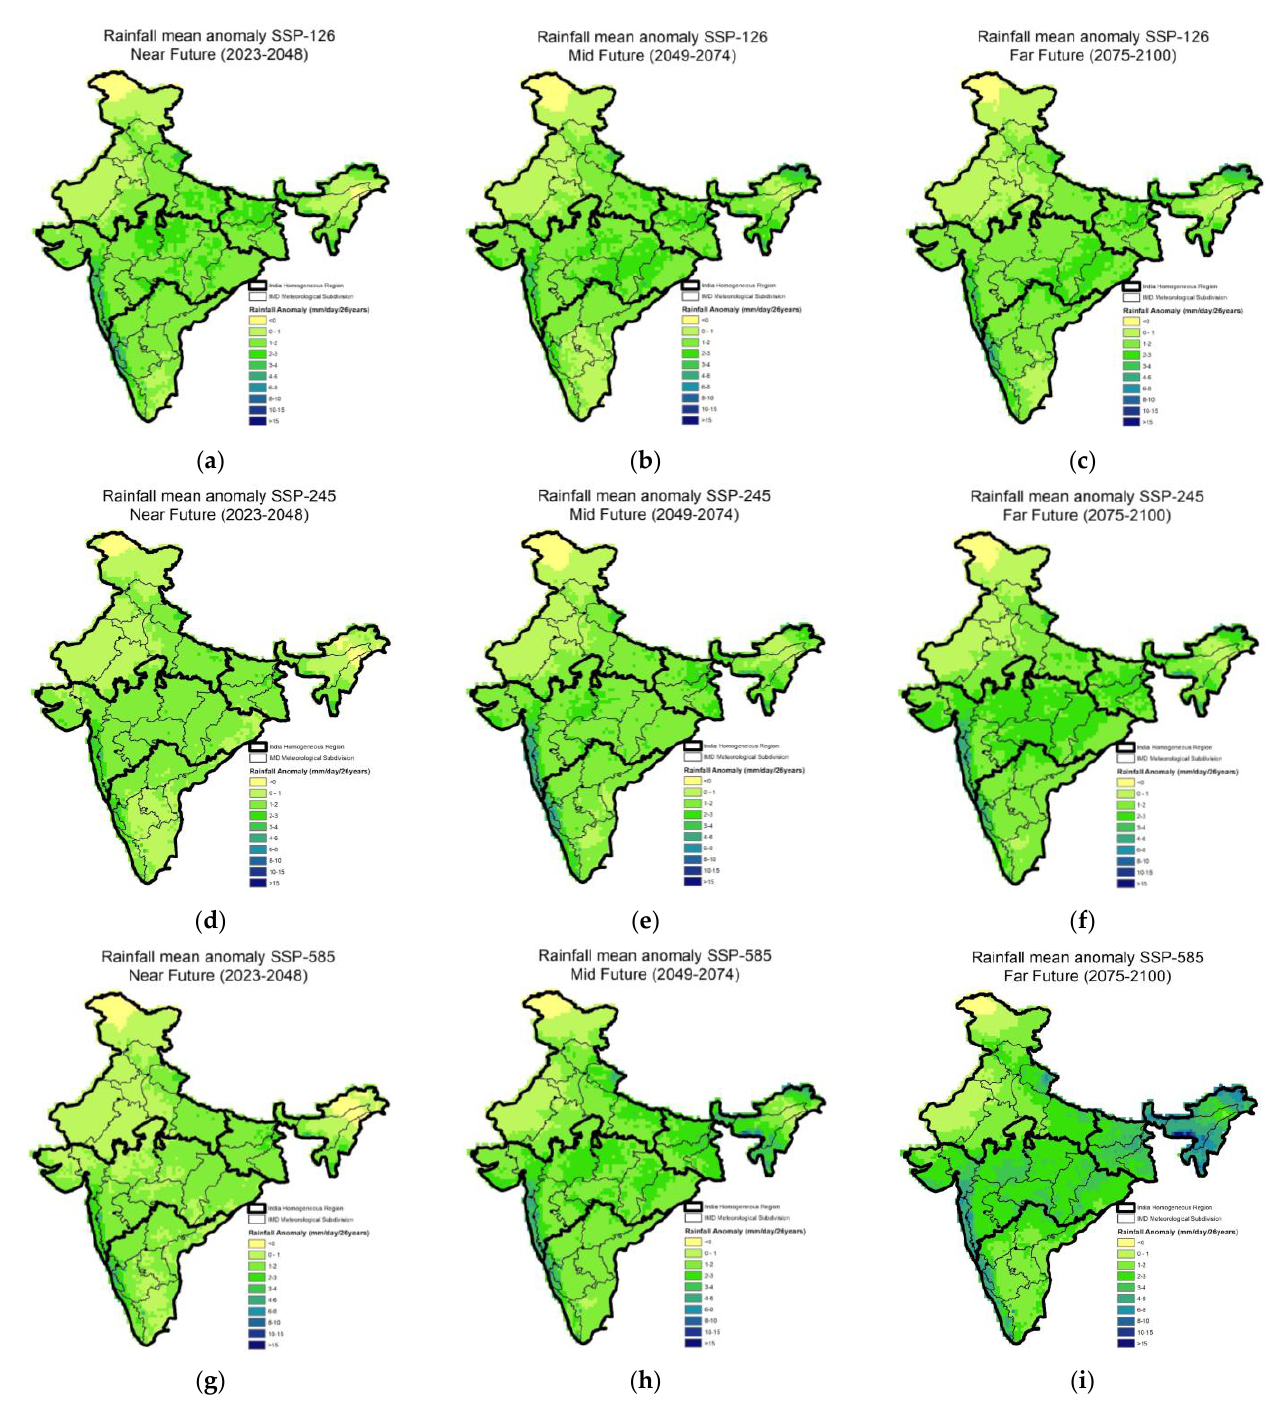
Figure 8. CMIP6 bias-corrected MME ensemble mean rainfall anomaly with reference to historical period (1989 – 2014) ( a ) mean rainfall anomaly SSP-126 Near future (2023 – 2048), ( b ) mean rainfall anomaly SSP-126 mid future (2049 – 2074), ( c ) mean rainfall anomaly SSP-126 far future (2075 – 2100), ( d ) mean rainfall anomaly SSP-245 near future (2023 – 2048), ( e ) mean rainfall anomaly SSP-245 mid future (2049 – 2074), ( f ) mean rainfall anomaly SSP-245 far future (2075 – 2100), ( g ) mean rainfall anomaly SSP-585 near future (2023 – 2048), ( h ) mean rainfall anomaly SSP-585 mid future (2049 – 2074), and ( i ) mean rainfall anomaly SSP-585 far future (2075 – 2100). A main monsoon core region, the Central India homogeneous region’s SPI index median is most likely to shift towards the wet side with some extreme wet events and